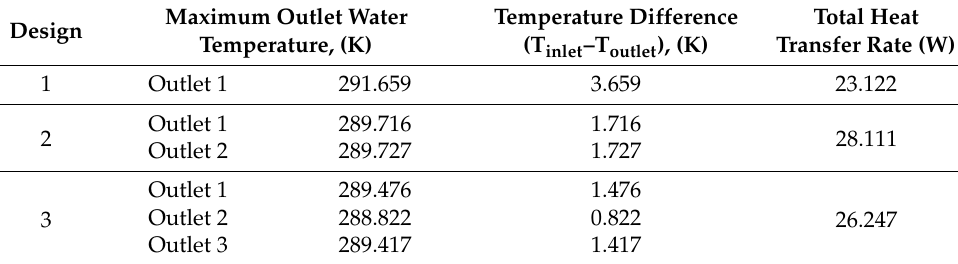
Table 7. Maximum outlet water temperature and total heat transfer rate.